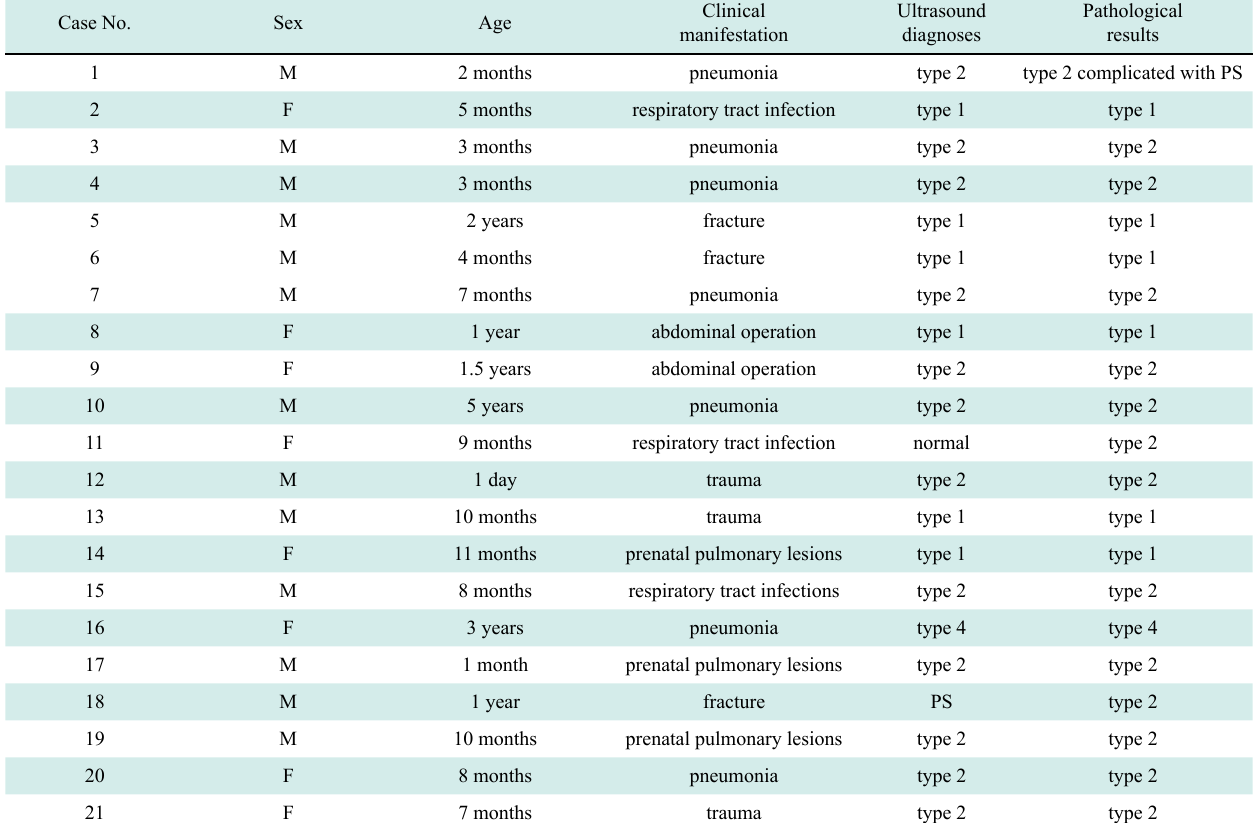
Table 1 Clinical details and ultrasonography diagnoses of the 21 cases Case